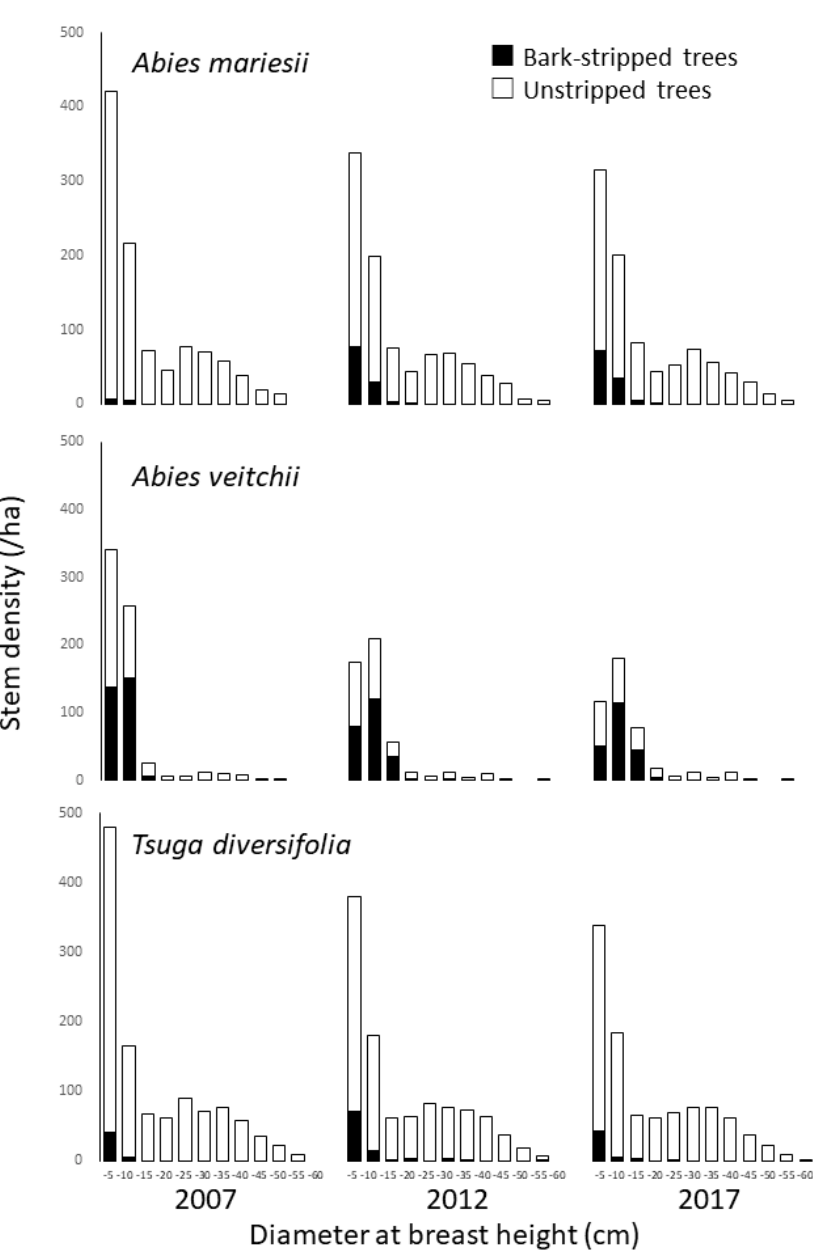
Figure 1. Diameter at breast height distribution of the three conifer species. Table 1. Size and density of new recruits.